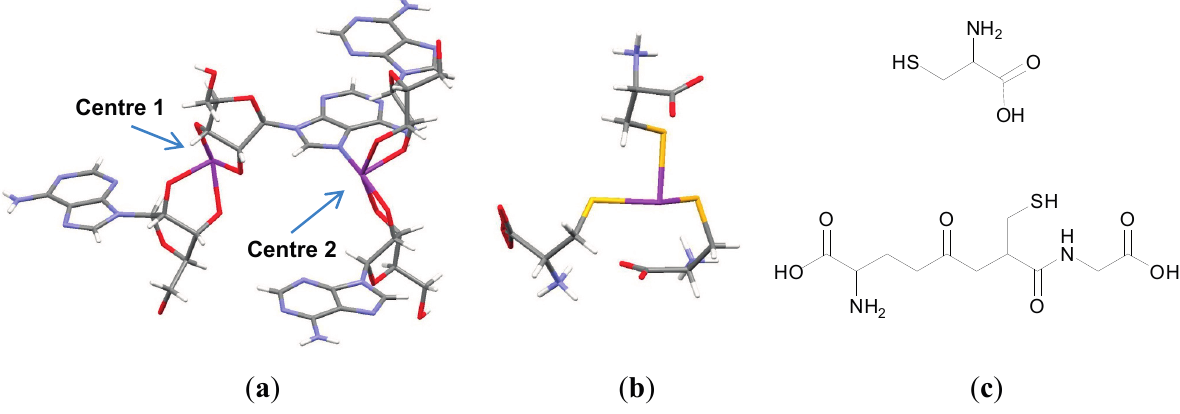
Figure 2. ( a ) Crystal structure of a Bi adenosine complex (CCDC: 634530) [21]; ( b ) Crystal Structure of Bi(Cys) 3 (CCDC: 685969) [23]; Colour code: C, grey; H, white; O, red; N, blue; S, yellow; Bi, purple; ( c ) Structures of cysteine (top) and glutathione